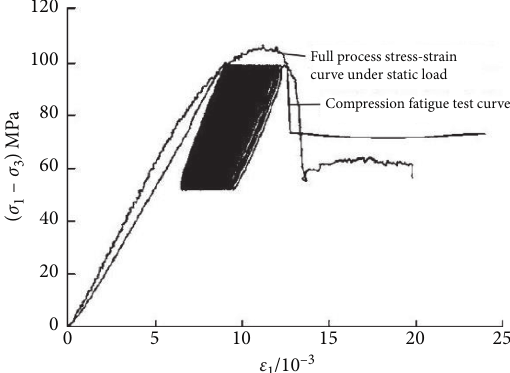
Figure 10: Fatigue curve and static curve of red sandstone under 15MPa confining pressure [51].